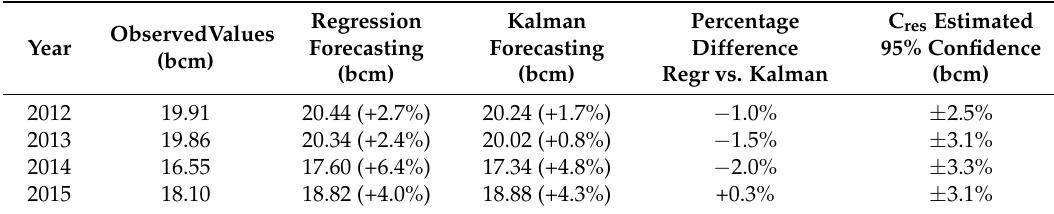
Table 3. Validation phase. C res values. Model identification phase: 1990–2011. A 95% confidence interval equal to ± 1.5% for all the explanatory variables has been assumed. Forecasting interval: 2012–2015. Standard regression compared to Kalman filter forecasting. The percentage errors in respect to the observed values are reported too.